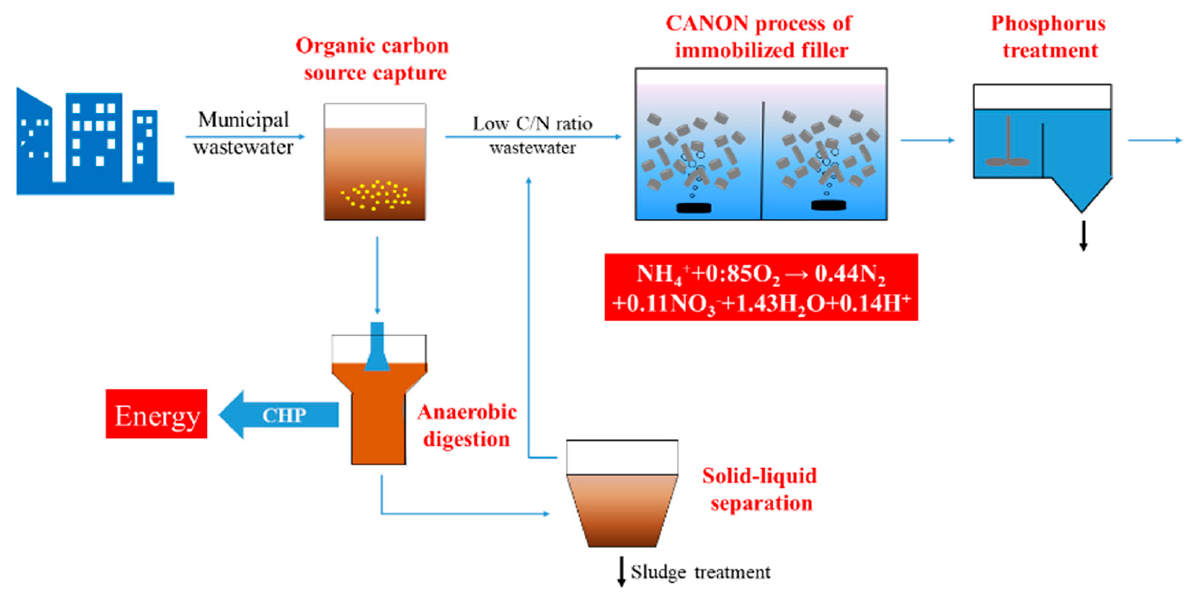
Figure 5. Conceptual model for municipal wastewater treatment based on the CANON process with AnGS immobilized fi ller.